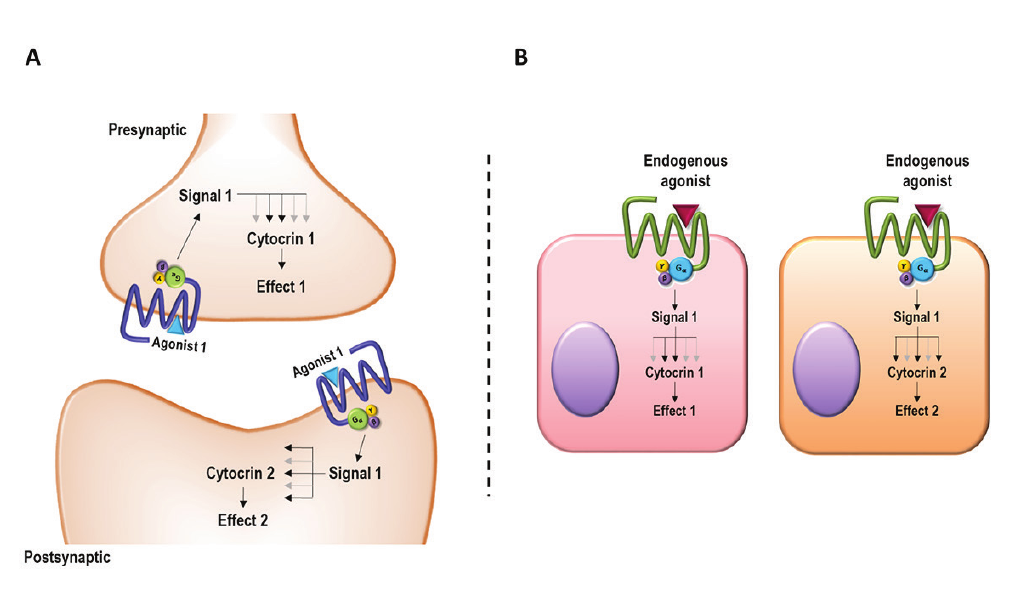
Figure 2: Scheme of differential effects underscored by a given receptor and a given agonist in two locations of a cell or in two different cells. Depending on the cytocrin pathways/mechanisms (see (25)) engaged after activation of a single receptor and a single pathway (e.g. the cAMP-dependent pathway), the effect may be different. Panel A: Biased receptor functionality in a neuron taking into account the same agonist and the same receptor located pre- versus postsynaptically. Panel B: Biased receptor functionality in two different cells in which the same agonist, the same receptor and the same pathway (e.g. the cAMP-dependent pathway) engages two different cytocrin pathways/